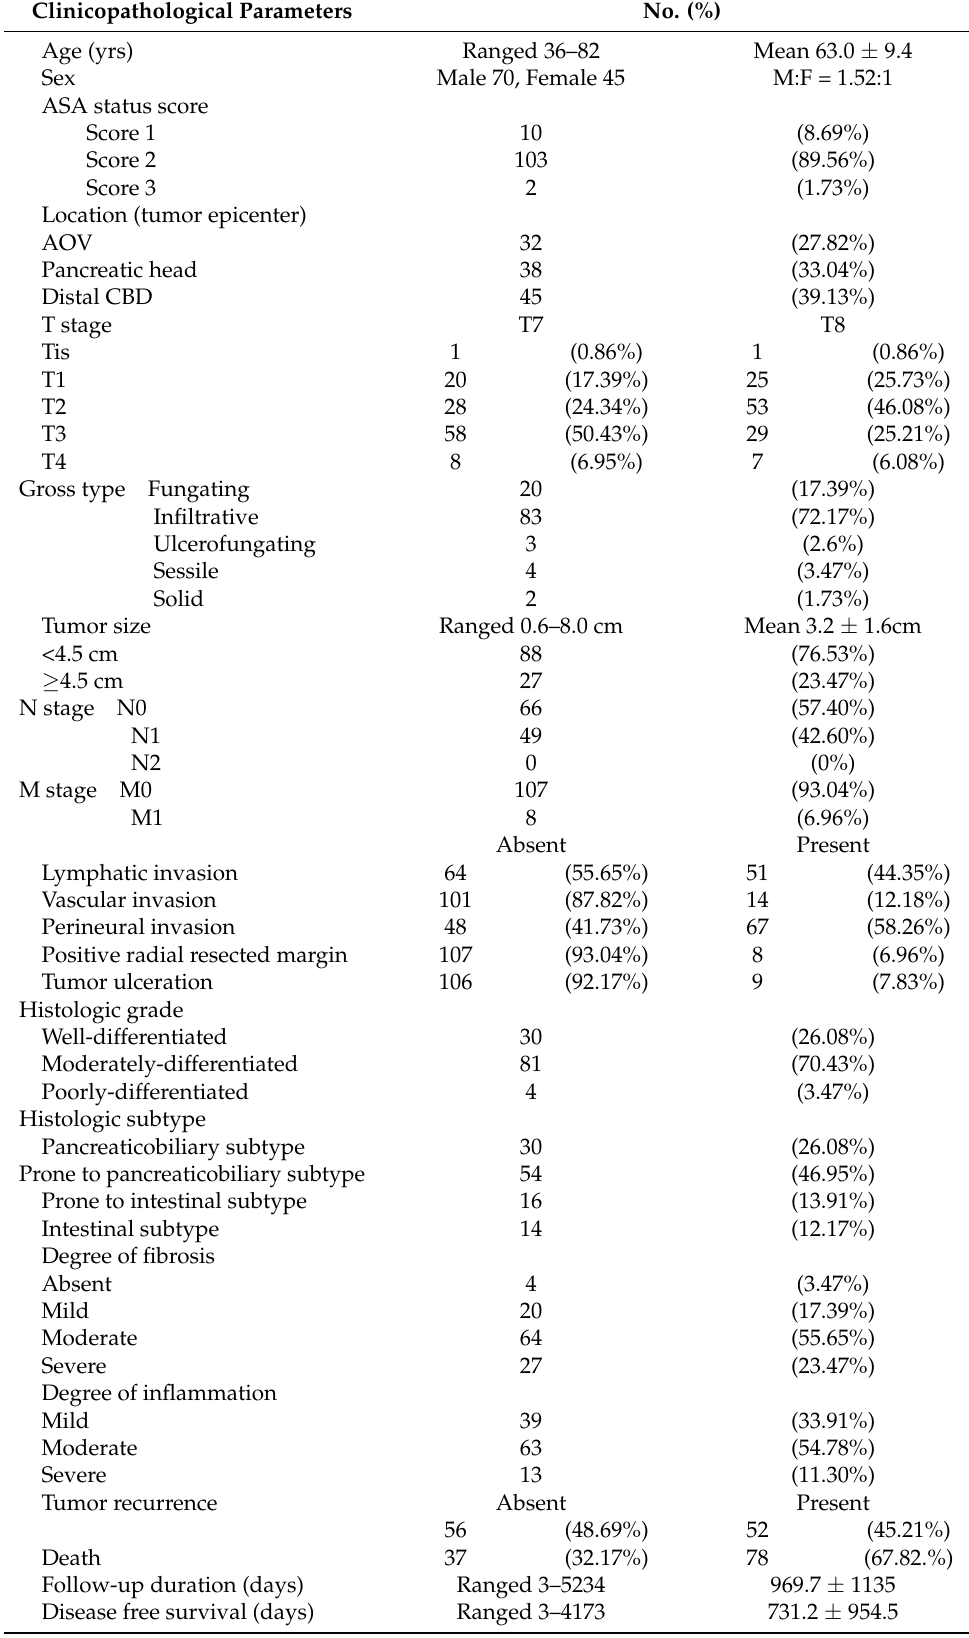
Table 2. Summary of clinicopathological data of the enrolled